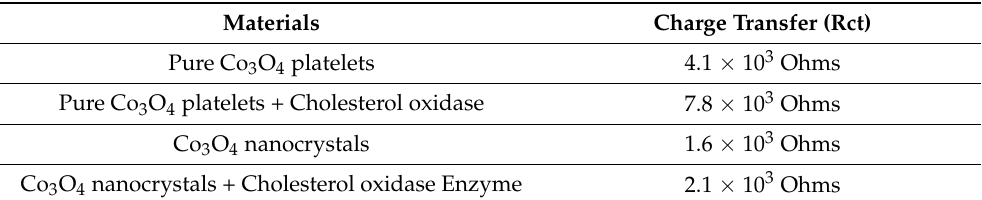
Table 3. Impedance values from EIS for various presented materials in this study.